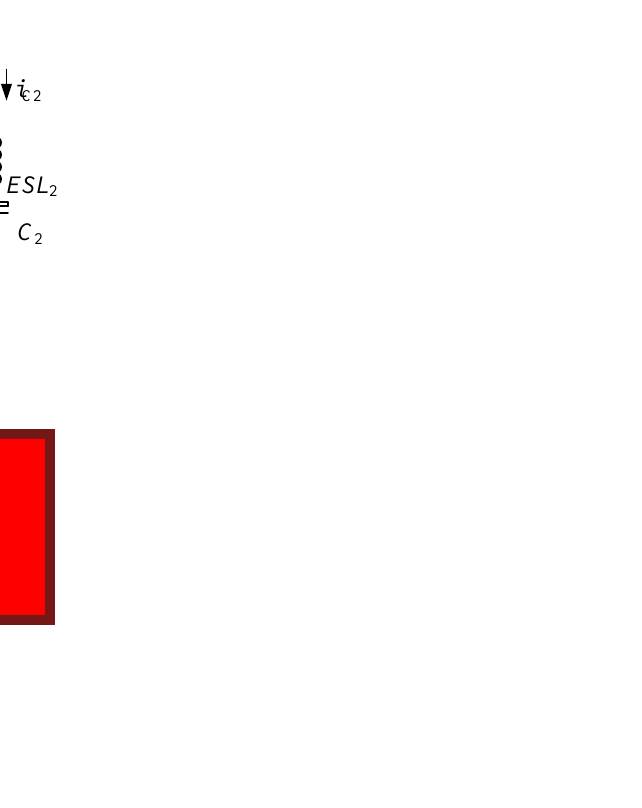
Figure 9. Coupled inductance model of multi-bus capacitor parallel laminated busbar. ( a ) Coupled inductor circuit model ( b ) Schematic diagram of stray inductance of laminated busbar.